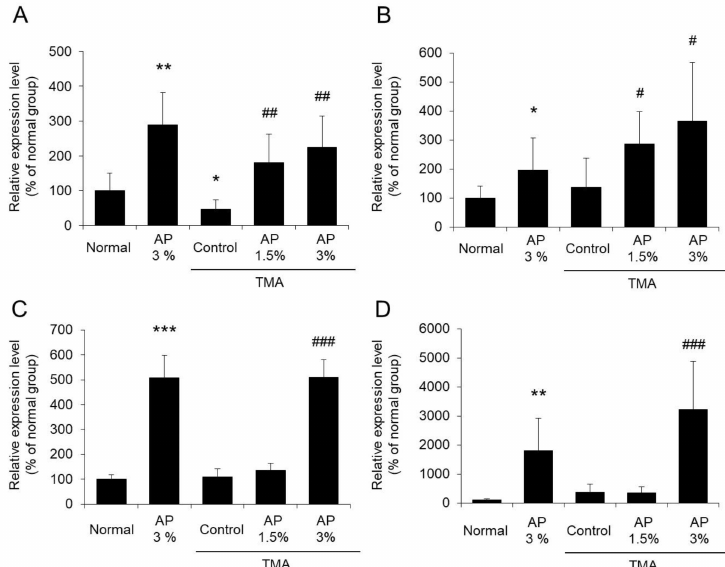
Figure 6. Bifidobacterium spp. ( A ), Lactobacillus spp. ( B ), Bacteroides fragilis ( C ), and Clostridium coccoides ( D ). Mice with atopic dermatitis induced by repeated application of TMA were given a diet with AP. The feces were collected from the colon, and the abundances of Bifidobacterium spp. ( A ), Lactobacillus spp. ( B ), Bacteroides fragilis ( C ), and Clostridium coccoides ( D ) in the gut microbiota were measured using real-time PCR (mean ± SD, N = 8, * p < 0.05 vs. normal group, ** p < 0.01 vs. normal group, *** p < 0.001 vs. normal group, # p < 0.05 vs. TMA-control group, ## p < 0.01 vs. TMA-control group, ### p < 0.001 vs. TMA-control